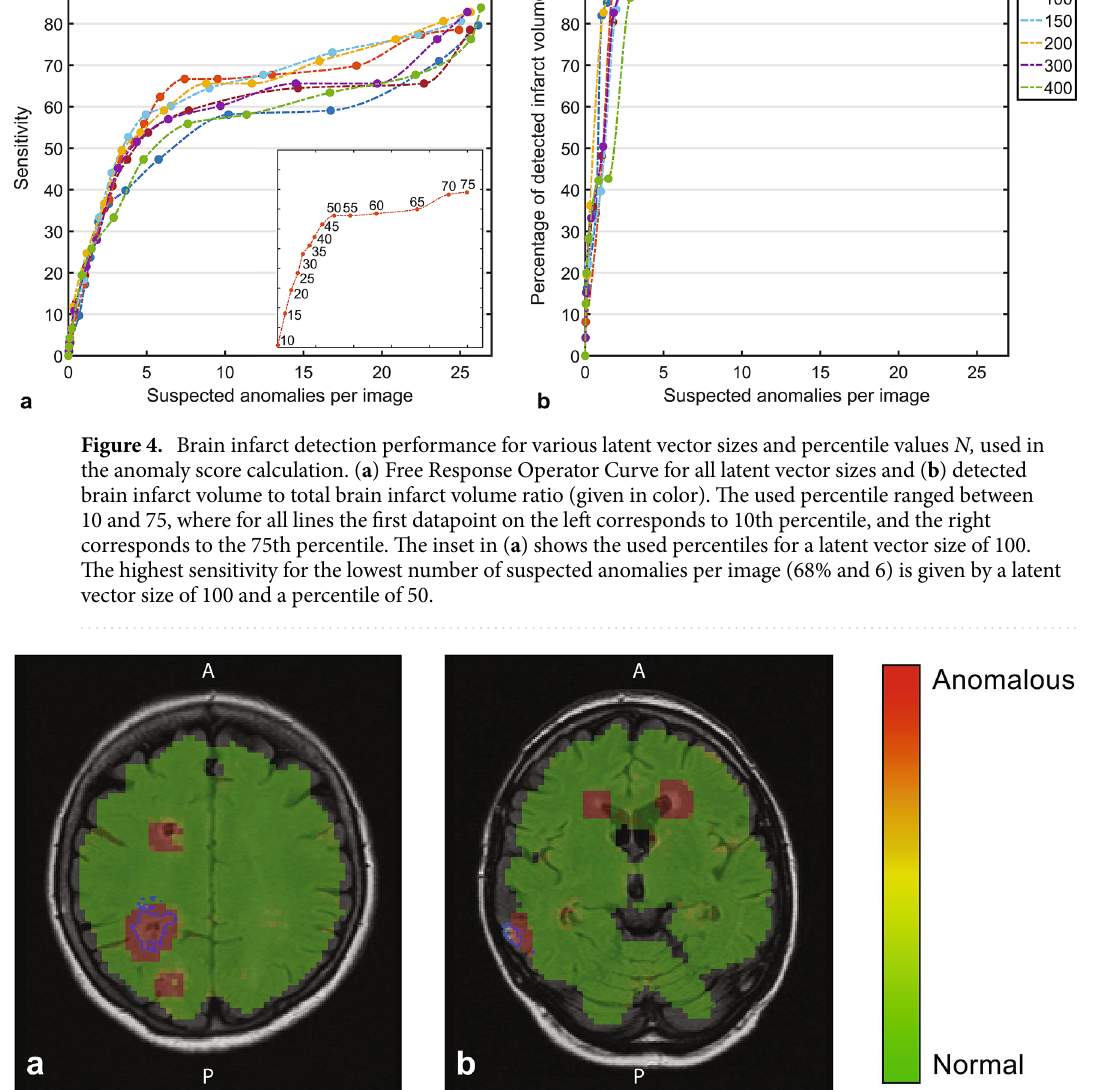
Figure 5. Anomaly score overlay maps on transversal image slices (T2-FLAIR images). A red color indicates an anomaly score ≥ 3, an anomalous location, where green and yellow an anomaly score < 3, normal tissue. The manually annotated brain infarcts are given by the blue outlines. An unannotated brain infarct located in a cranial slice can be observed in ( a ), anterior (A) of the annotated brain infarct. The anomaly at the posterior (P) side of the brain infarct in ( a ) is only delineated in a subsequent image slice. ( b ) Detected cortical brain infarct, and two other suspected anomalous locations, caused by white matter hyperintensities at the horn of the